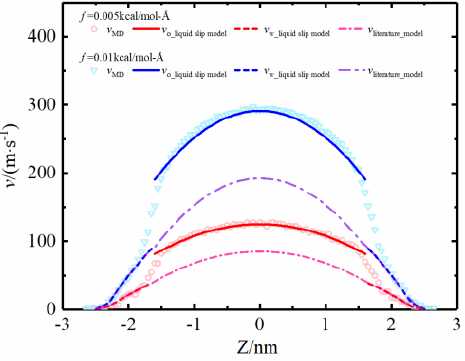
Figure 10. The comparison of velocity profiles calculated by “liquid slip” model and molecular simulation data.